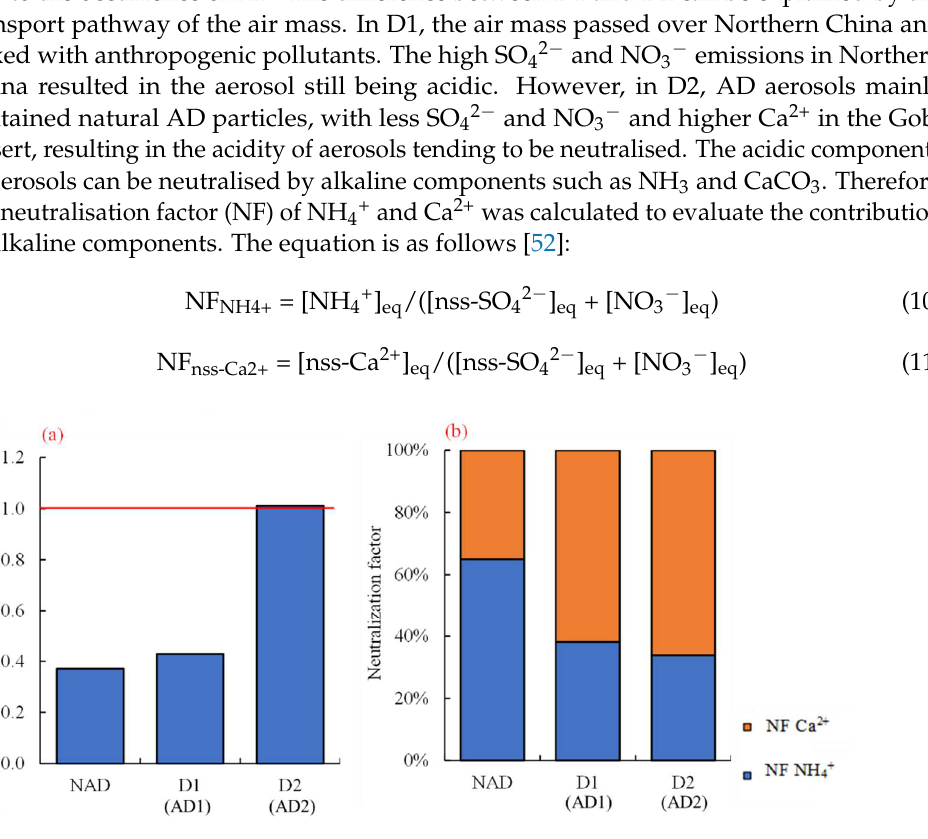
Figure 4. The ratio of cation ions (CA) to anion ions (AN) ( a ) and neutralisation factor ( b ) during the sampling period. D1 and D2 are the sampling periods that contain the AD1 and AD2 events, respectively.